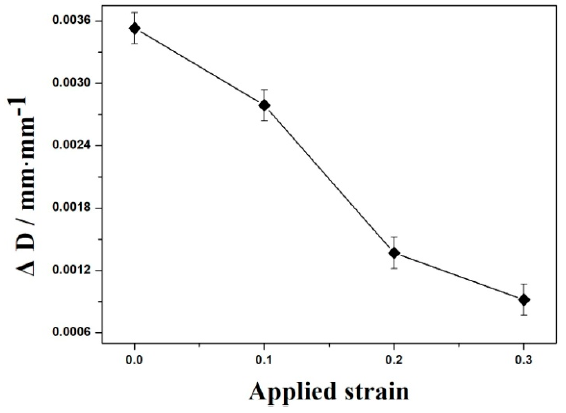
Figure 8. The changing tendency of ∆𝐷 with the strain.